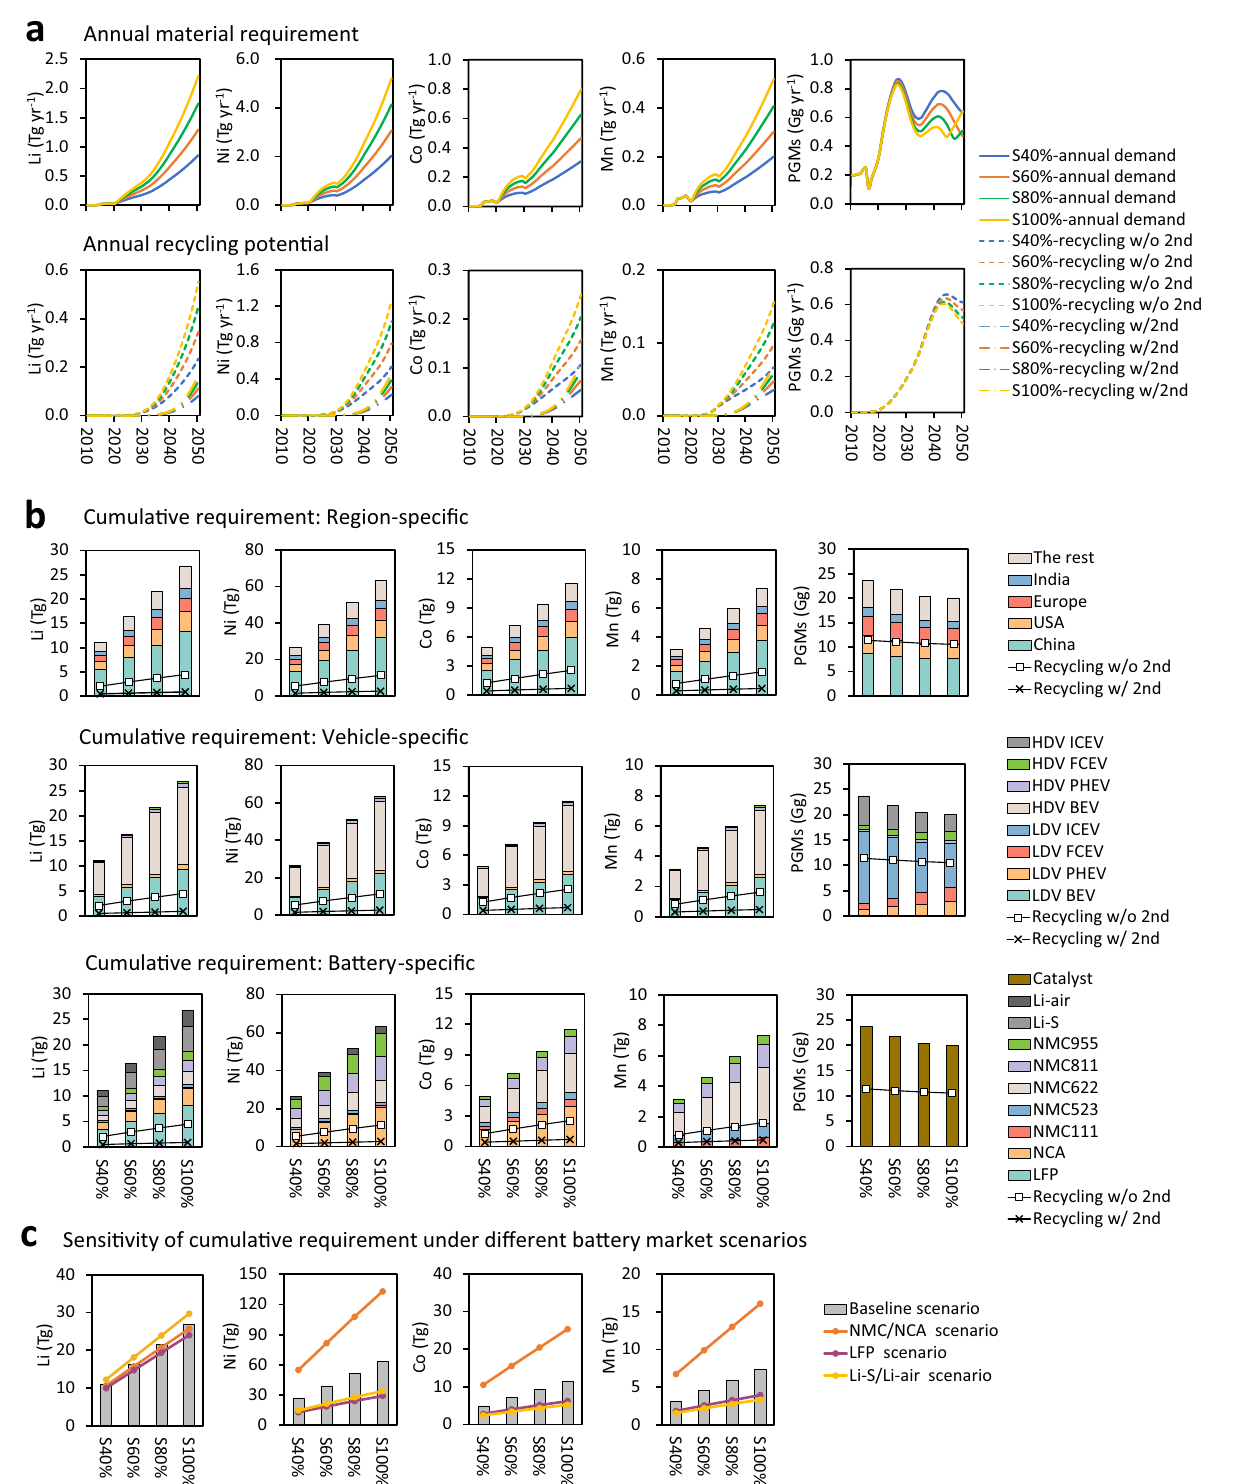
Fig.2|Annualandcumulativecriticalmetalrequirementsandtheclosed-loop recycling potential of critical metals. a Annual demand and recycling potential with or without a second use. b Region-speci fi c/vehicle-speci fi c/battery-speci fi c cumulative (from 2010 to 2050) demand for critical metals and the cumulative potential secondary production from recycling. c Sensitivity of cumulative requirement under different battery scenarios. NMC/NCA scenario illustrates that the market share of NMC/NCA will increase to 100% by 2050. “ Recycling w/o 2nd ”